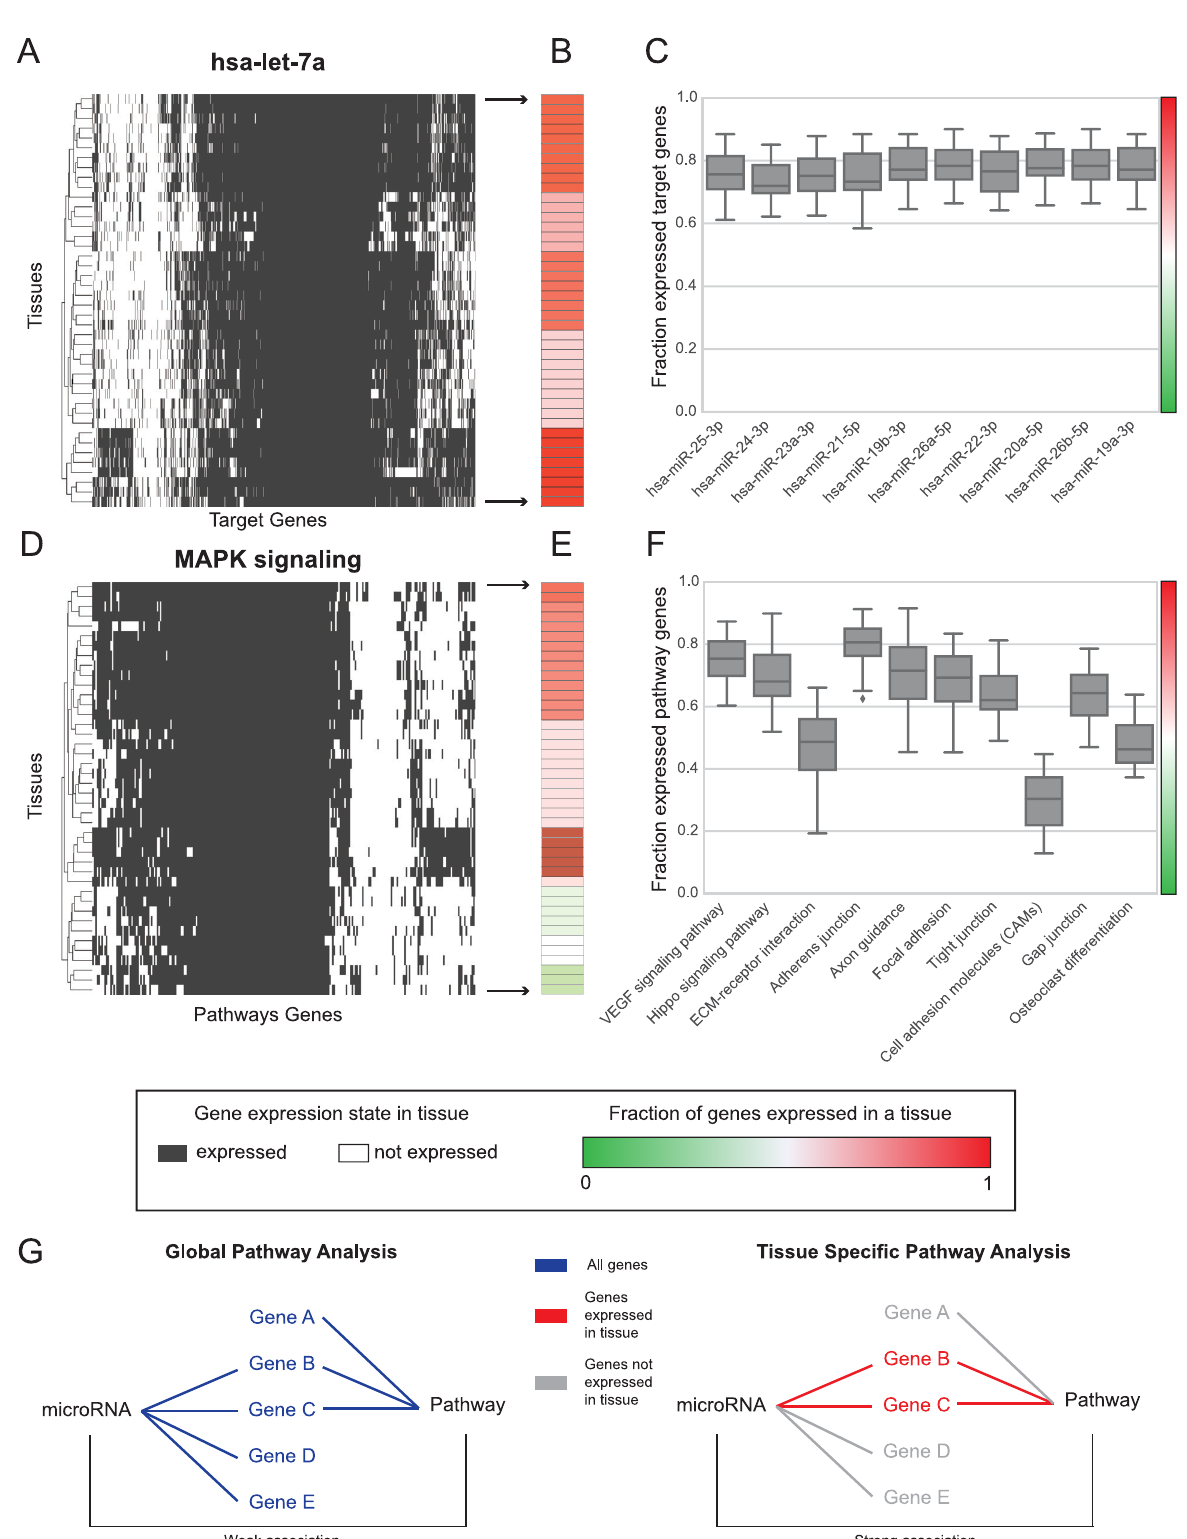
Fig 1. miRNA target genes and pathway genes are tissue specific. (A) Heatmap of all target genes of hsa-let-7a and their expression in 42 human tissues. Tissues are depicted in rows, genes in columns. (B) Fraction of target genes of hsa-let-7a expressed in each tissue, color coded in green (0) to